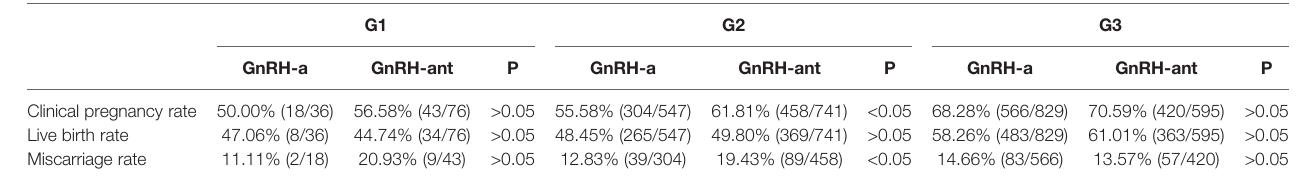
TABLE 5 | Comparison of pregnancy outcomes between different treatment schemes in different subgroups. G1 G2